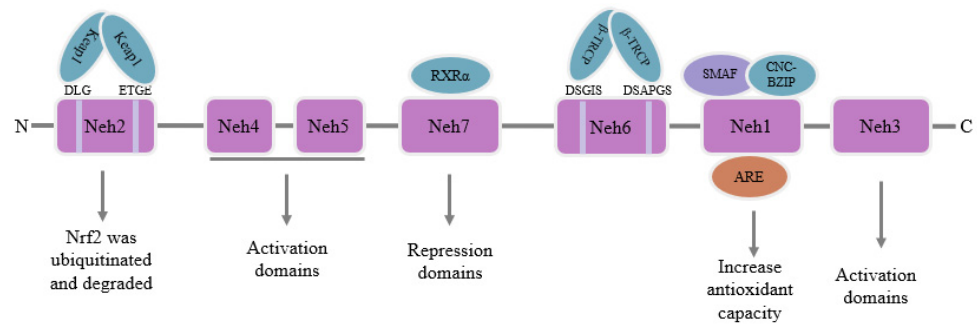
Figure 2. Schematic diagram of the structure of Nrf2.